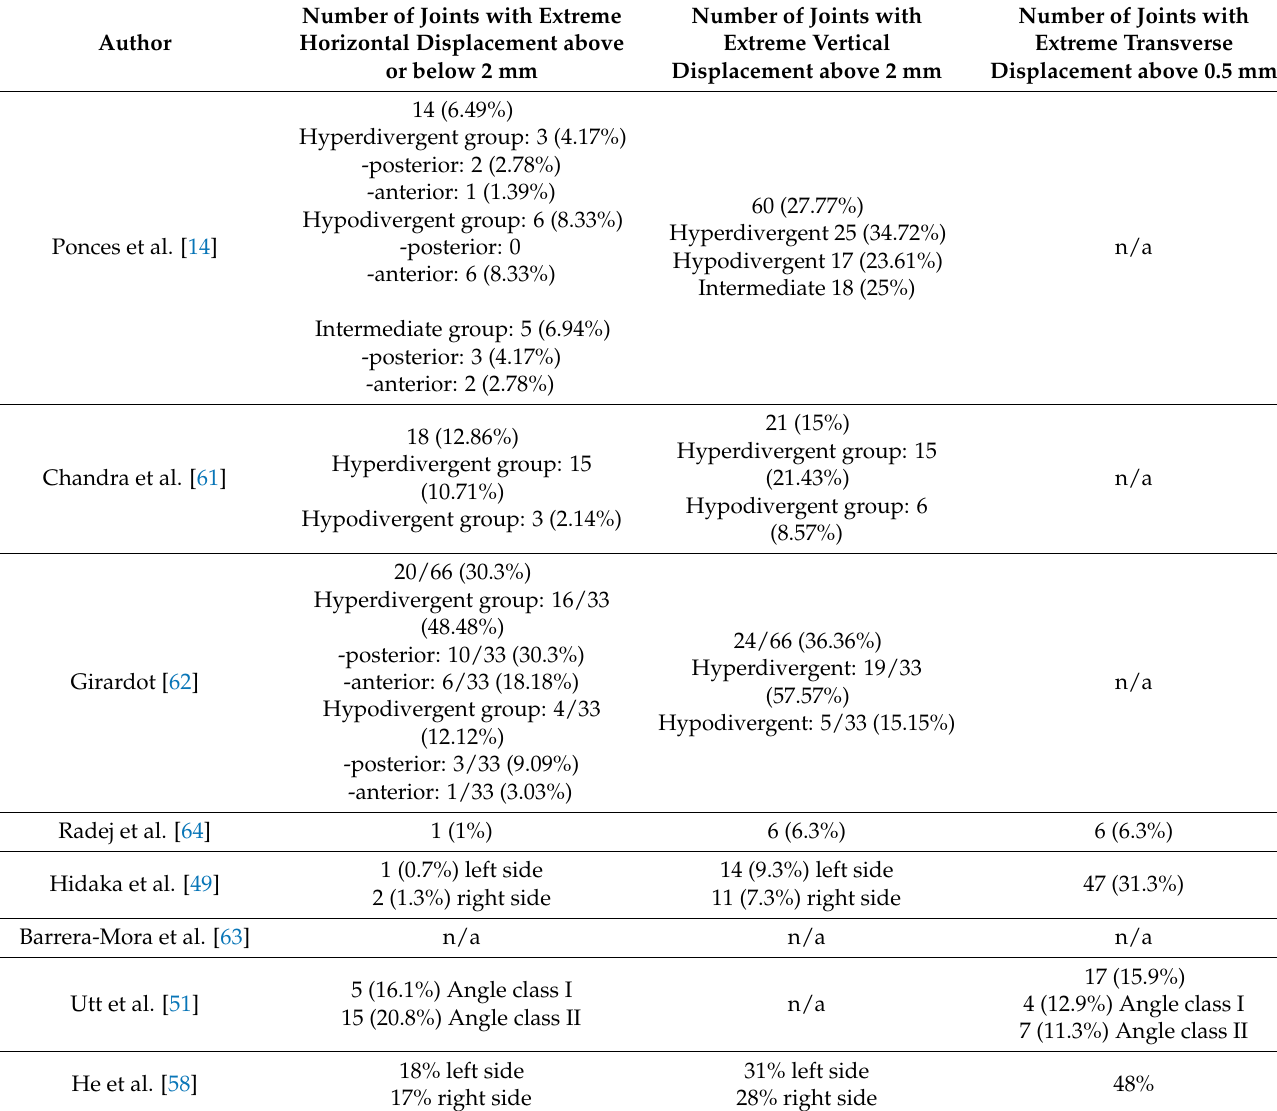
Table 5. Number of condyles with extreme displacement.